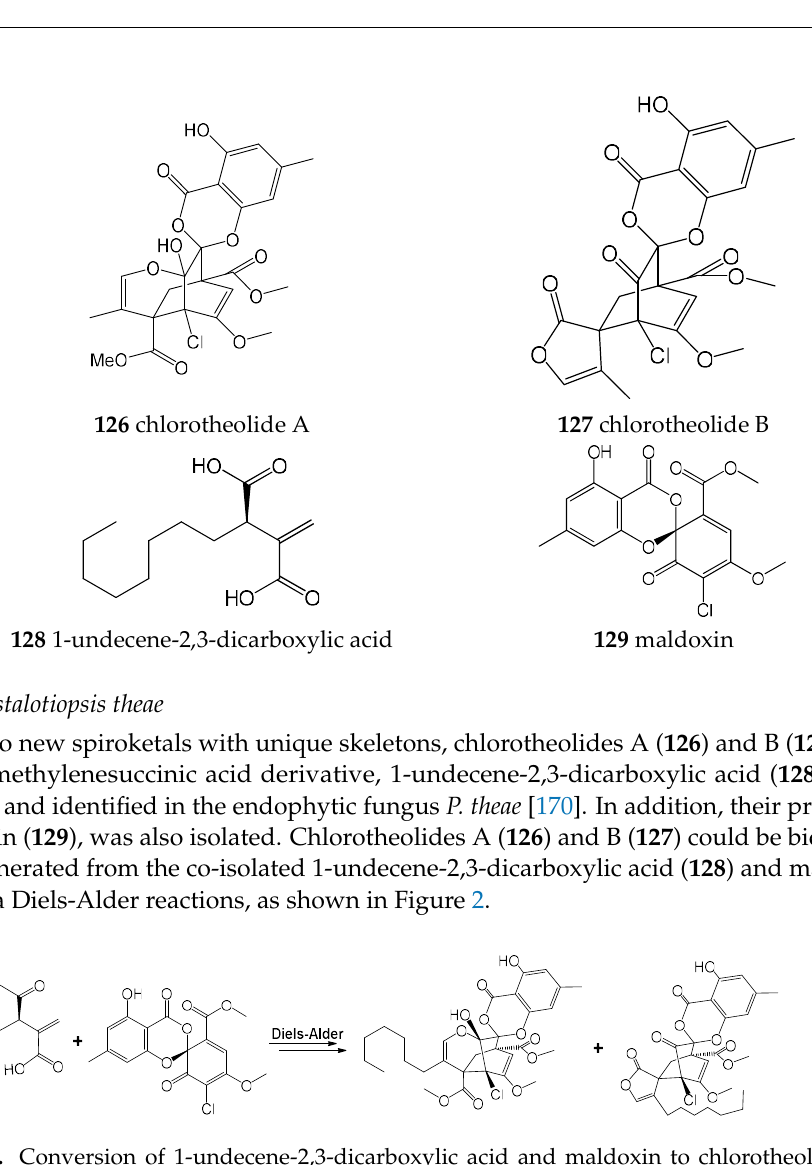
Figure 2. Conversion of 1-undecene-2,3-dicarboxylic acid and maldoxin to chlorotheolides via Diels-Alder reactions [170]. The hypothetical biosynthetic pathways for chlorotheolides A ( 126 ) and B ( 127 ) are shown in Figure 3.